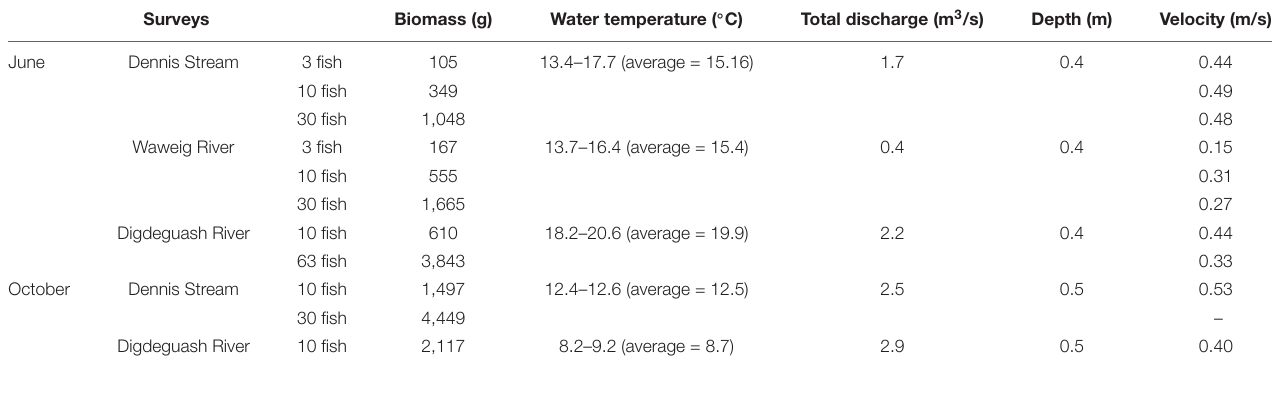
TABLE 1 | Environmental conditions within each stream during the experiment periods.